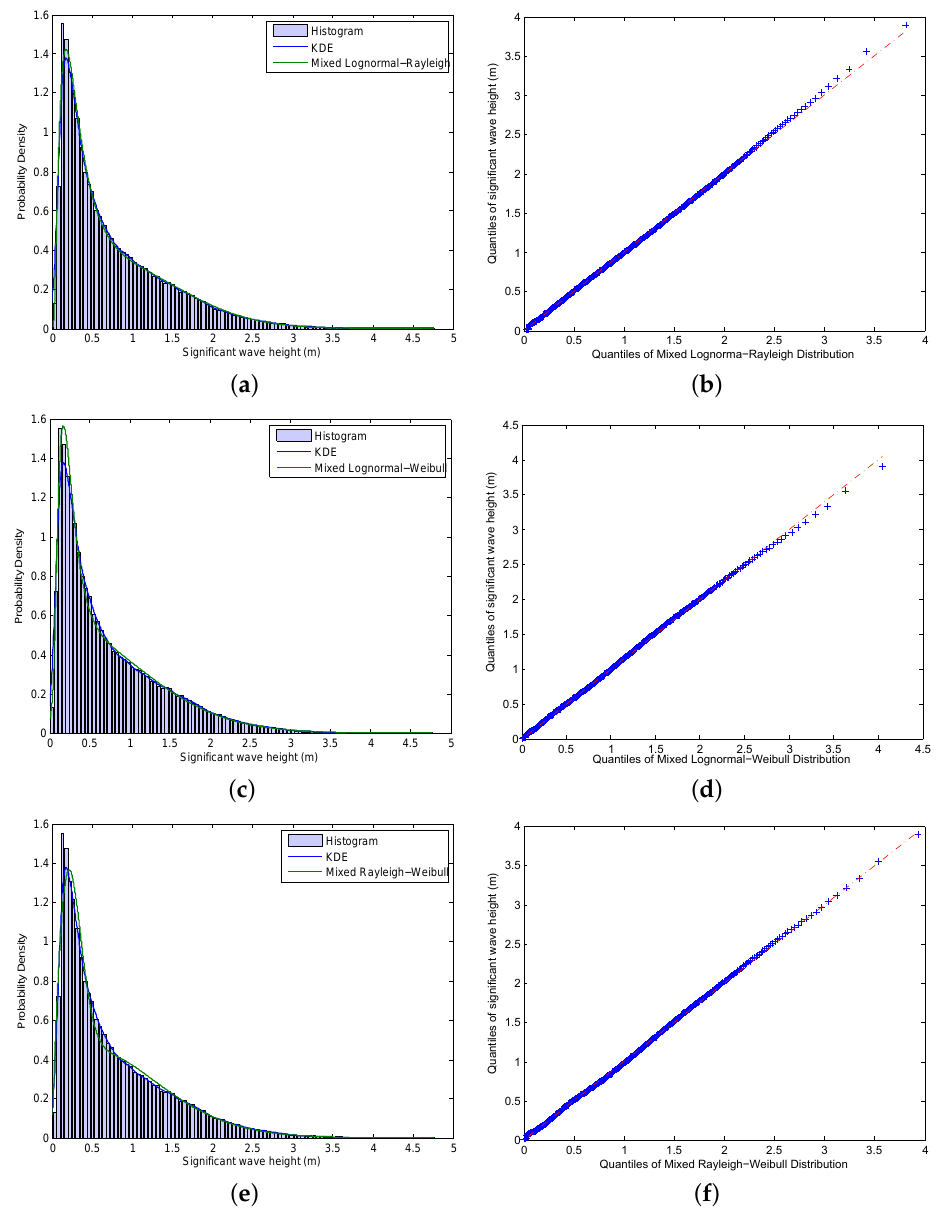
Figure 11. ( a – f ) Estimated kernel density of the significant wave heights and the mixed-distributions from Lognormal-Rayleigh, Lognormal-Weibull, and Rayleigh-Weibull distributions of the significant wave heights with the corresponding Q-Q plots of the mixed distributions of the significant wave heights. Table 3. R-square test and the corresponding parameters for each fitted mixed-distribution. Distribution Parameters Weights